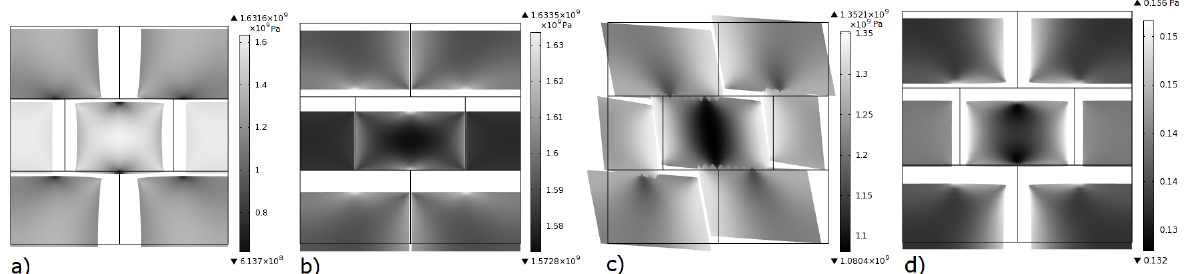
Figure 3. Configurations for macro deformations (cid:101) x = [ 1 0 0 ] ( a ), (cid:101) x = [ 0 1 0 ] ( b ), (cid:101) x = [ 0 0 1 ] ( c ), and (cid:101) x = [ 0 0 0 ] , p ( 0 ) = 1 ( d ). Colormap represents von Mises stress in Pascals. Crack stiffness: G = 1 10 13 Pa. Deformation magnification: 10 × ×